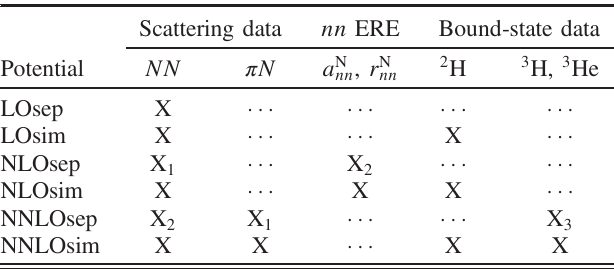
TABLE I. Objective functions for the various nuclear inter- actions in this work. Included data types are marked with “ X. ” For sequential optimization, the subscript “ i ” indicates at what stage the model is optimized to that data. Excluded data types are indicated with “ (cid:4) (cid:4) (cid:4) ”